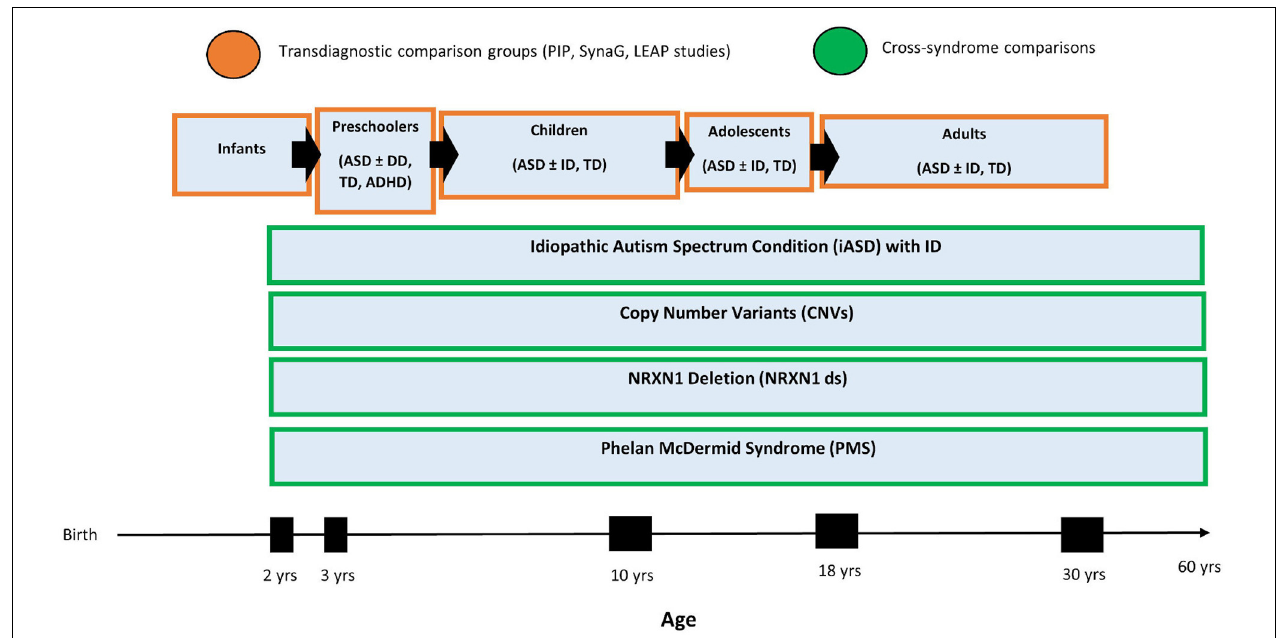
FIGURE 1 | SynaG Study lifespan design and planned comparison groups. The PIP sample includes n = 500 participants, the LEAP sample includes n = 700, and the SynaG study will include a final sample of n = 230 participants.